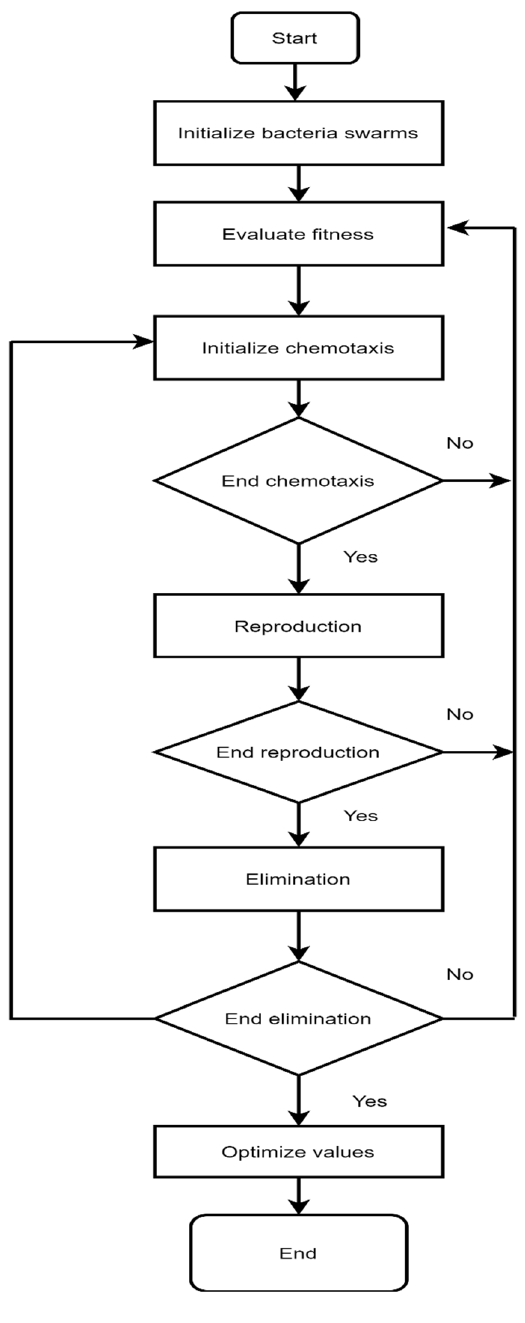
Figure 12. The framework of BFOA [86].